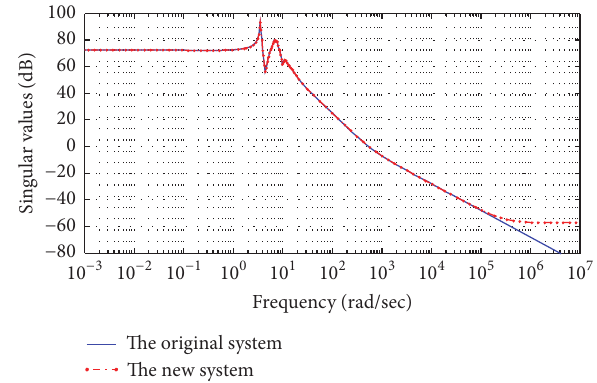
Figure 7: Frequency response of the original and reduced system.